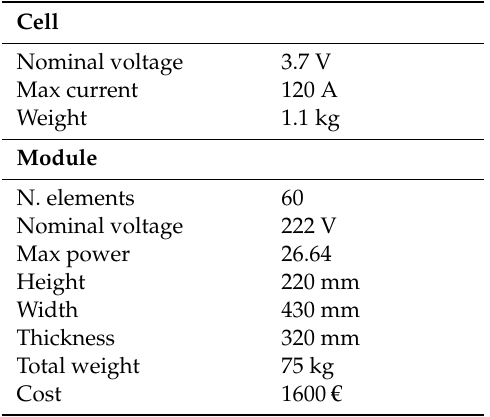
Table 10. Series Battery Modules